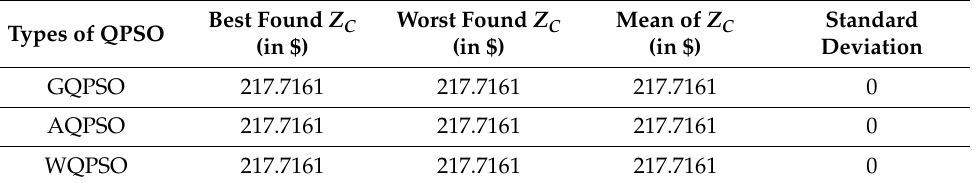
Table 4. Statistical Analysis for various types of QPSO for Case-I of Example 1.